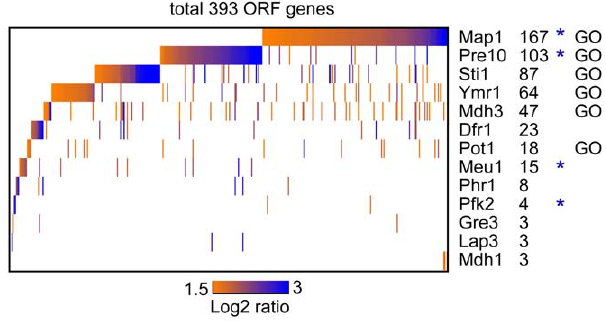
Figure 4. Selected novel RNA-binding proteins bind to distinct sets of mRNAs. (A) Heat map of mRNAs associated with indicated proteins. The color code (orange-blue) indicates the fold-change (log 2 ratio scale) of the respective feature in the affinity isolation compared to mock control microarray data. The number of mRNA targest for each protein is indicated next to the name of the protein. A star (*) denotes association with own mRNA. ‘GO’ indicates that GO terms are significantly enriched among targets (see Table